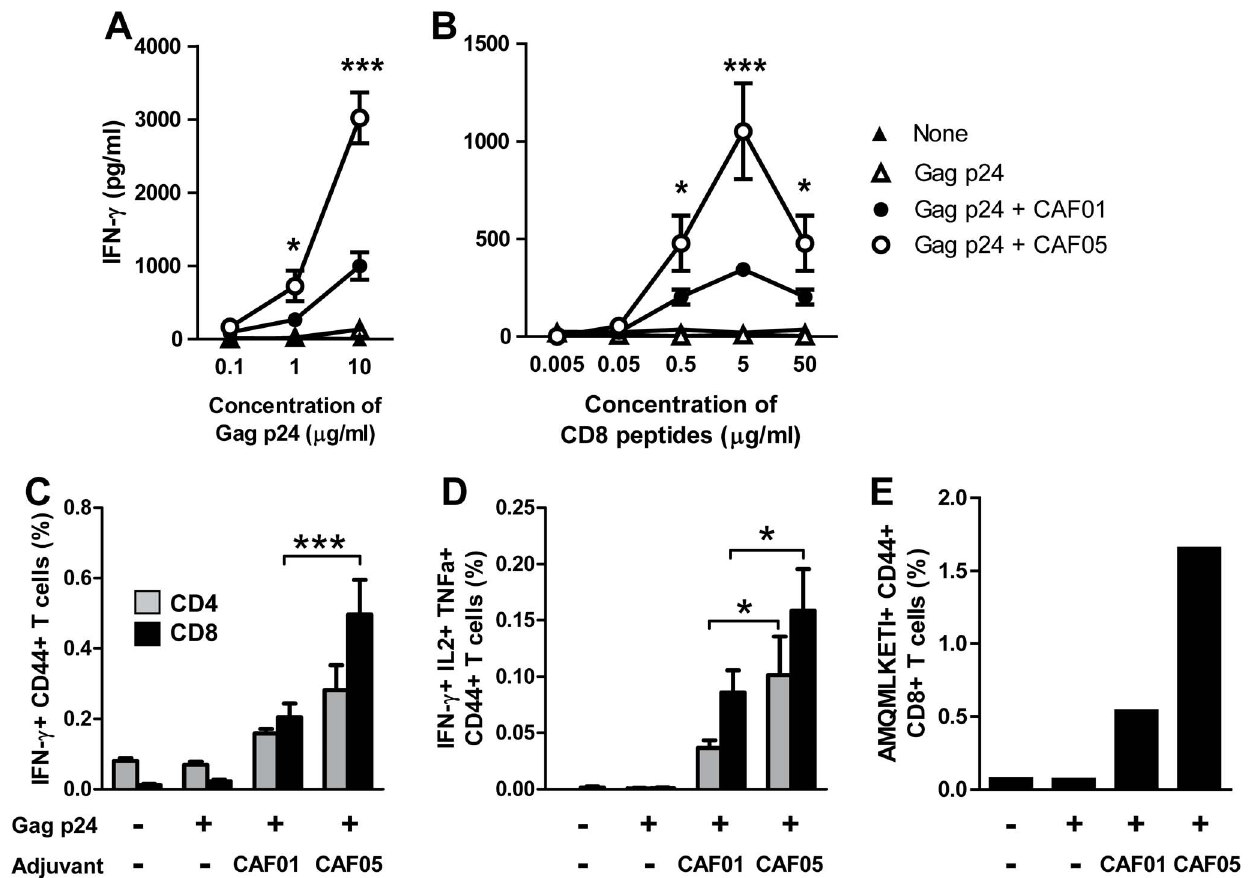
Figure 1. Gag p24 formulated with CAF05 induces antigen-specific CD4 and CD8 T-cell responses in CB6F1 mice. Mice were immunized three times i.p. with 20 m g Gag p24 protein alone (open triangles) or adjuvanted in CAF01 (black circles) or CAF05 (open circles). Naı¨ve mice were used as a negative control (black triangles). The T-cell response in spleens was determined three weeks after the last immunization by restimulation in vitro with either whole Gag p24 protein (A), the CD8 T-cell epitope AMQMLKETI-containing peptides 16–17 (B) or 10 m g/ml of a mix of overlapping Gag p24 peptides (C-D). T-cell responses were assessed by ELISA to determine the release of IFN- c in supernatants after 4 days (A-B) or flow cytometry to determine the percentage of IFN- c + CD44 hi cells of the total CD4 (grey bars) or CD8 (black bars) T cell population (C) and the percentage of cells expressing both IFN- c , TNF-a and IL-2 after 8 hours of stimulation (D). (A-D) Each data point represents the mean (n=6) + / 2 SEM. Where the CAF05 adjuvant induced a statistically significantly higher response than CAF01 determined by two-way ANOVA and the Bonferroni post test, this has been indicated: * p , 0.05, *** p , 0.001. (E) The percentage of AMQMLKETI-specific CD44 hi cells of the total CD8 T-cell population was also determined in blood pooled within each group 1 week after the last